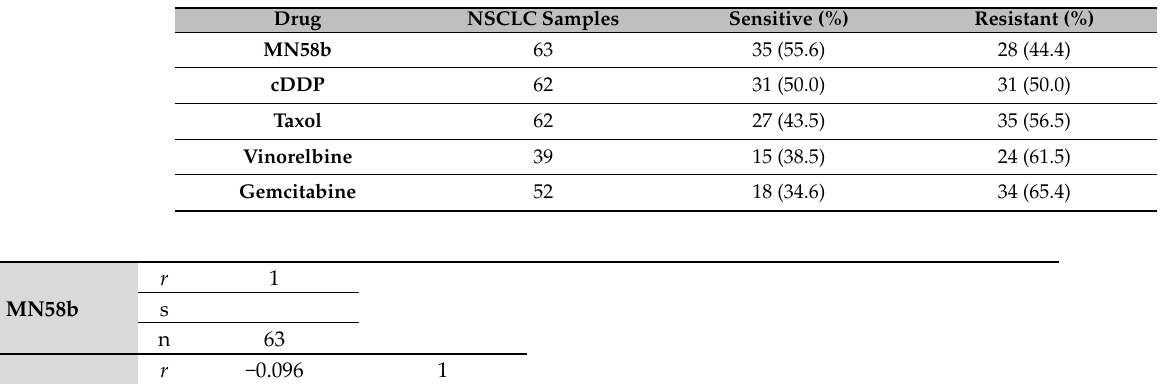
Table 1. Responsiveness of NSCLC primary cultures to different antitumor agents. Resected tissues from NSCLC patients were dissociated to obtain primary cultures that were treated for 10 days with different concentrations of the indicated drugs. Cell viability was determined by Alamar blue. The number of total samples examined in each case and the number of samples sensitive or resistant to each treatment are reported with their proportions (%).